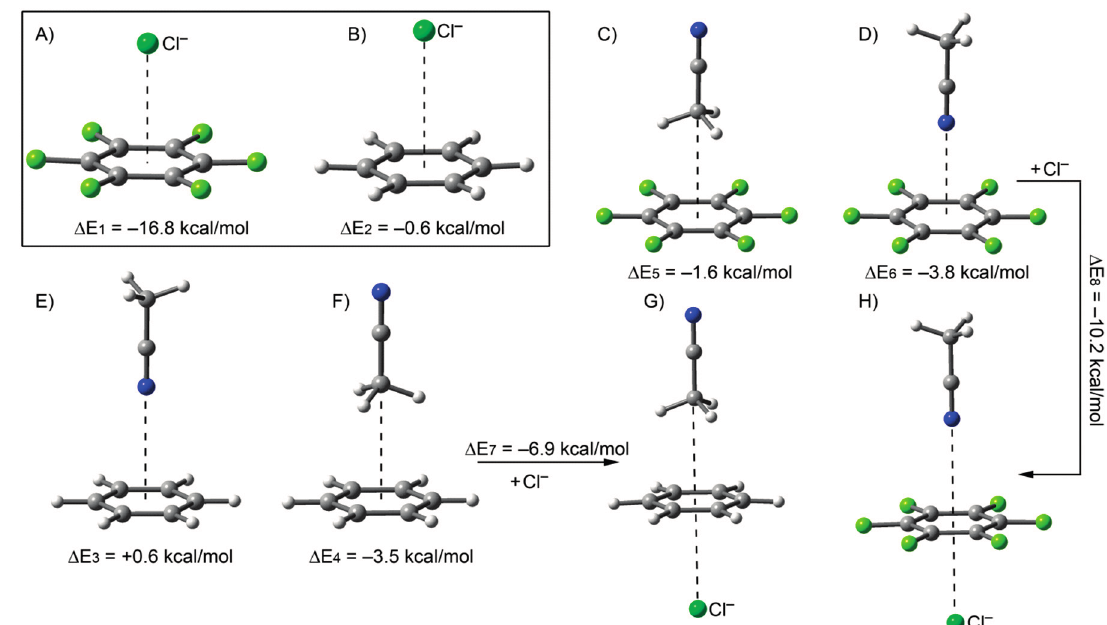
Figure 3. Energy optimized geometries of some anion– π , lp– π , C–H··· π model